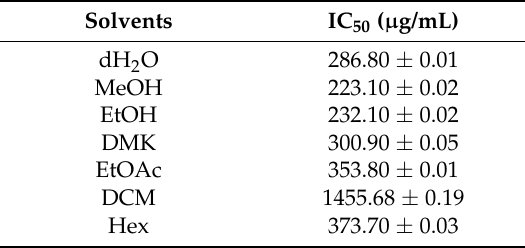
Table 2. IC 50 μ g/mL values. Table 2. IC 50 µ g/mL